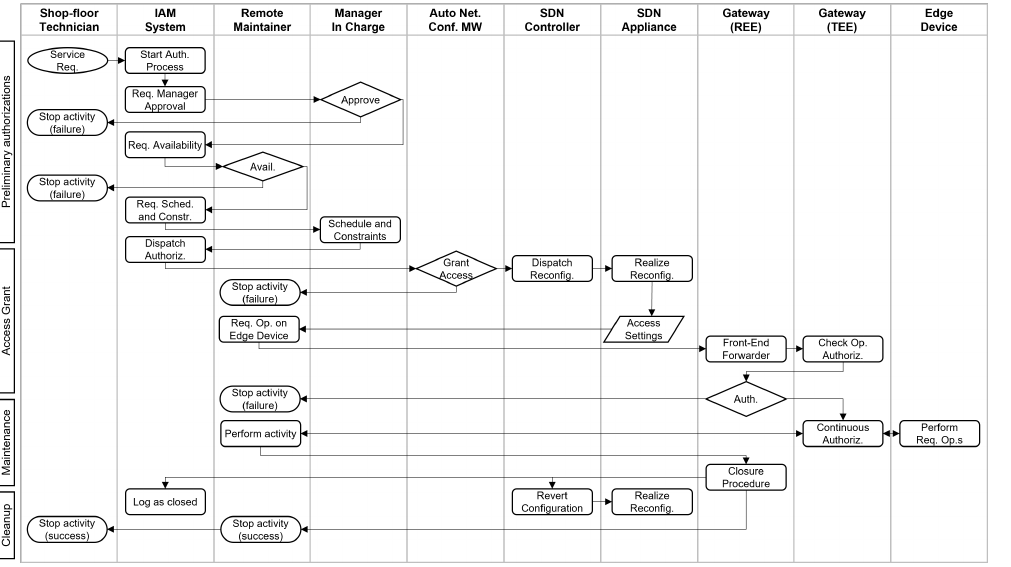
Figure 11. Industry 4.0 Remote Maintenance Scenario